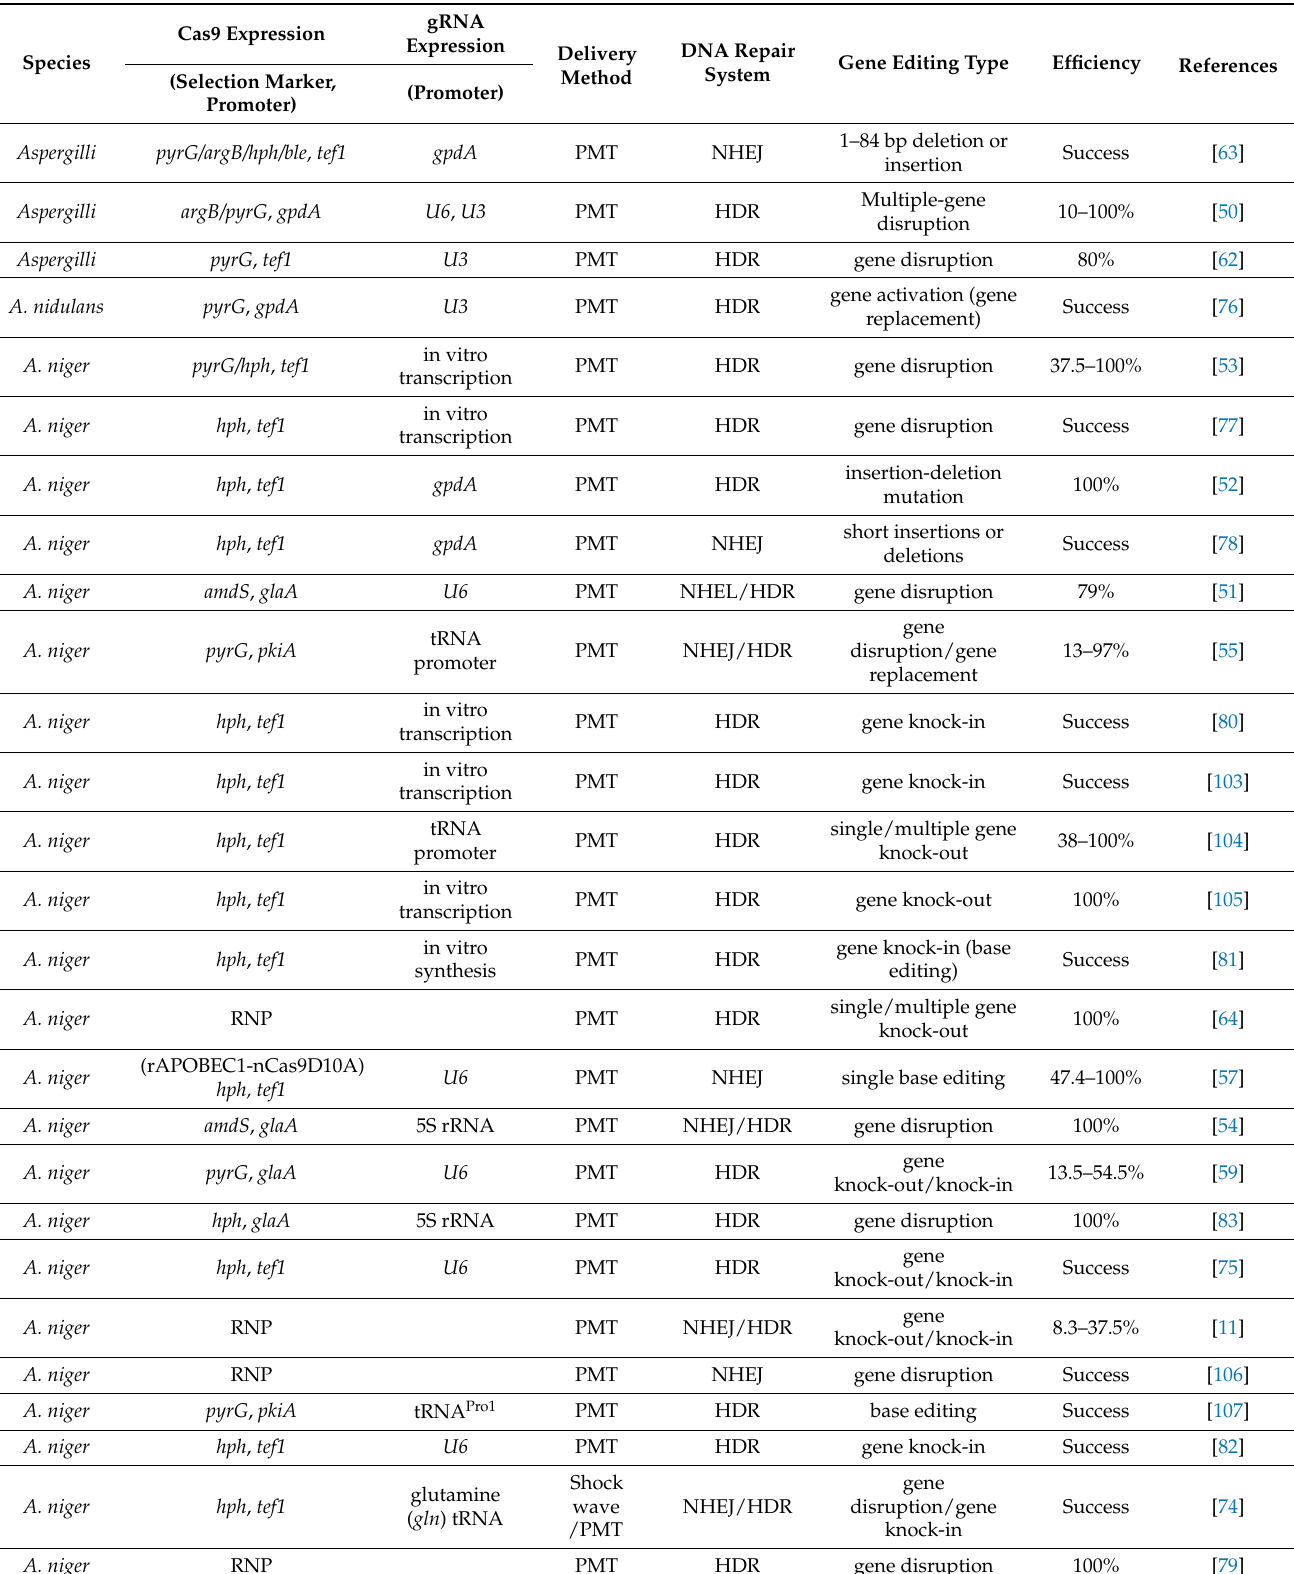
Table 1. The development and application of the CRISPR/Cas9-based genome editing system in Aspergillus